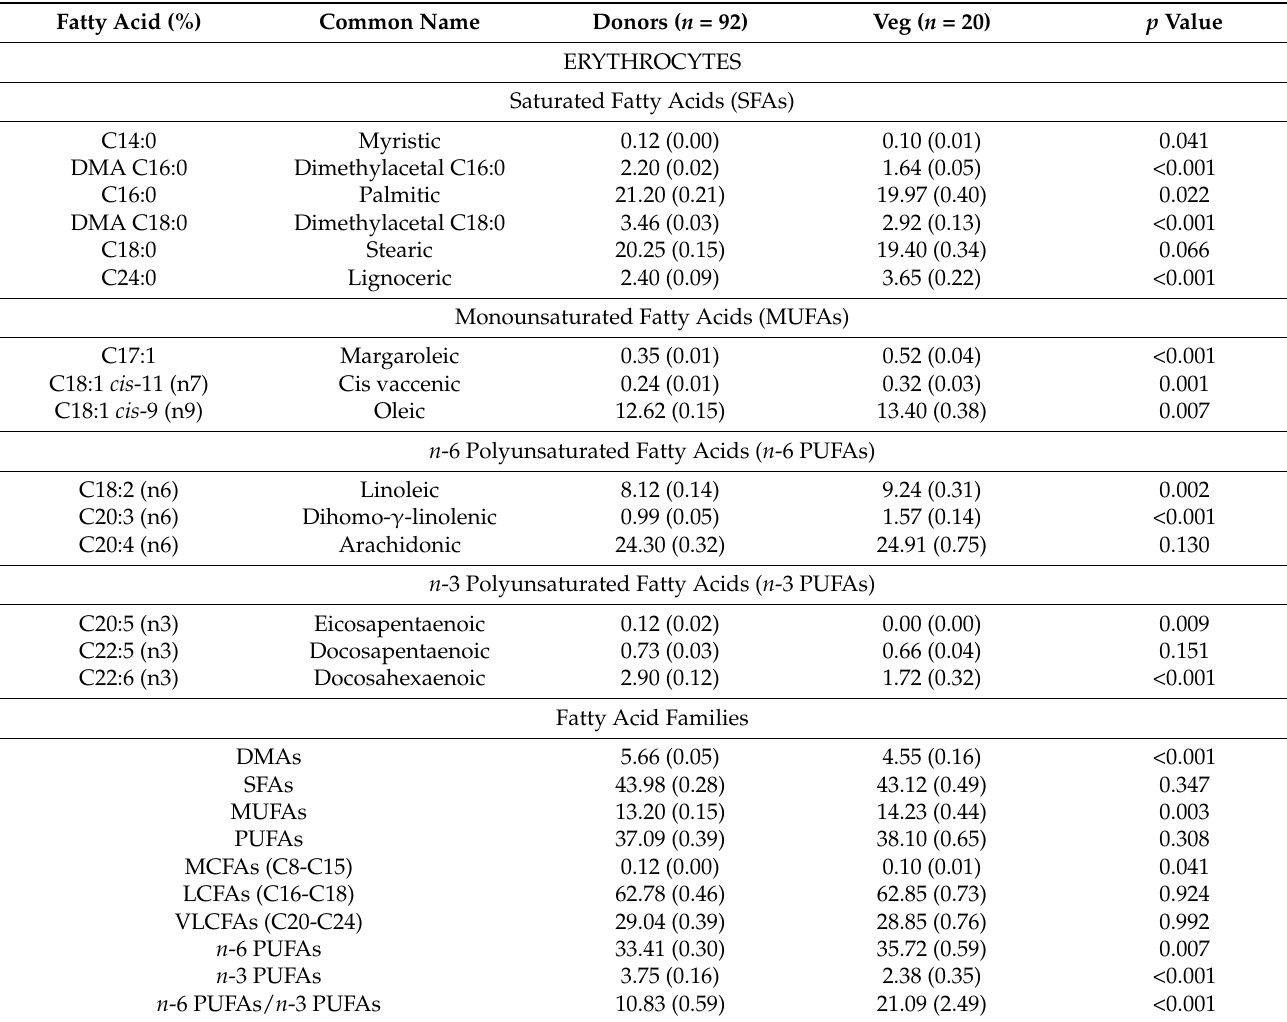
Table 9. Erythrocytes and plasma fatty acid composition (g/100 g of total fat) of the omnivore